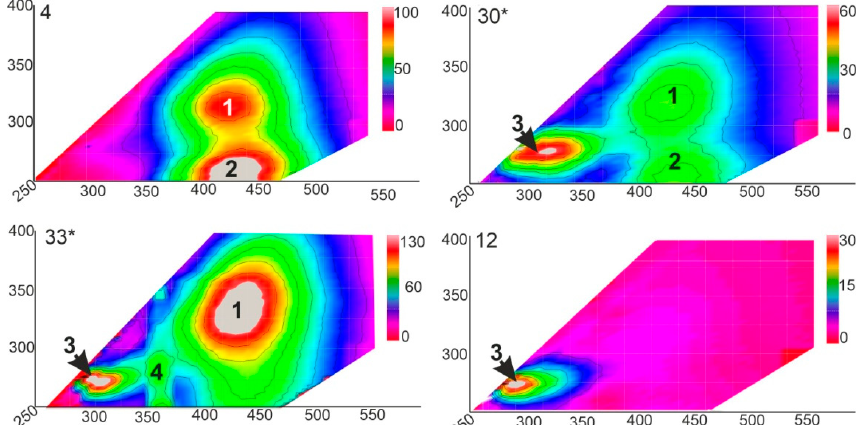
Figure 4. The representative excitation-emission (EEM) spectra of DOM, sample numbers are indicated in the left upper part of each spectrum. The peak marks are 1—hDOM-1; 2—hDOM-2; 3—tyrDOM; 4—trpDOM. * tabular ground ice samples are marked with an asterisk. Table 5. Fraction composition of dissolved organic matter (DOM).